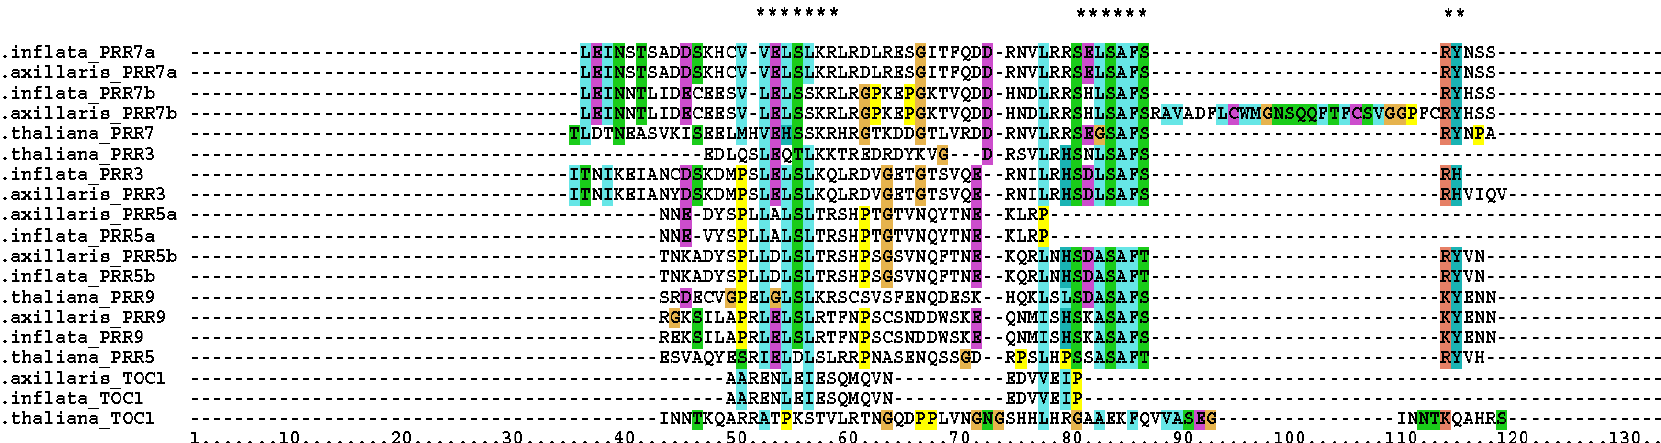
Figure 2. Repression motifs of PSEUDO-RESPONSE REGULATORS (PRRs) local alignment. Arabidopsis thaliana (A.thaliana), Petunia axillaris (P.axillaris), and P. inflata (P.inflata), L( E / D )( L / I )S( L / I )( R / K )R and SXXSAF( S / T )( R / Q )( Y / F ) regions are depicted by asterisks (*).